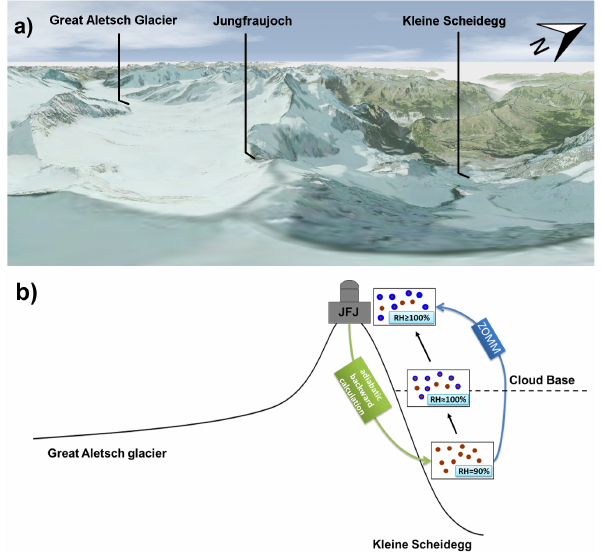
Figure 1. In (a) a panorama picture is shown to give an overview of the surroundings of the Jungfraujoch. The topography is shown in a sketch (b) along with the subsaturated conditions, conditions at the cloud base and at the Jungfraujoch. The green arrow shows the adiabatic backward calculations for the conditions at subsatu- rated conditions (initialization point of ZOMM; RH = 90%) with the measurements performed at the Jungfraujoch. The blue arrow shows the direction from the initialization point of the model until the end state of the simulation, which is at the Jungfraujoch. Brown dots indicate aerosol particles, blue dots cloud